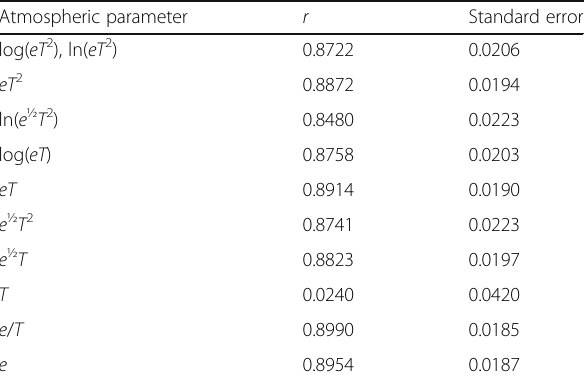
Table 2 Correlation between the emissivity of the atmosphere and both water vapour pressure, e, and temperature, T, from